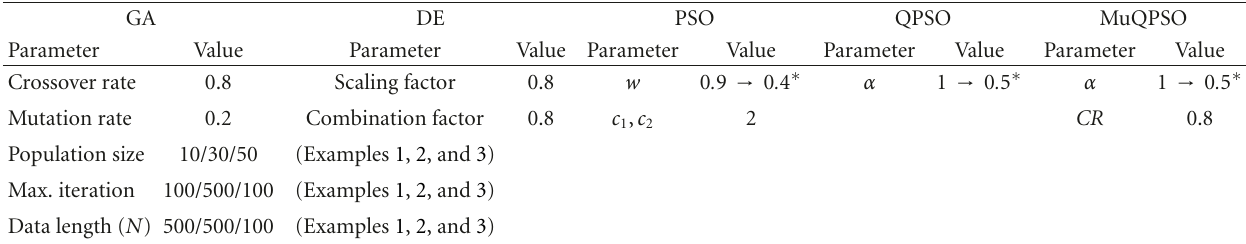
Table 1: Parameter settings for the competitor algorithms.